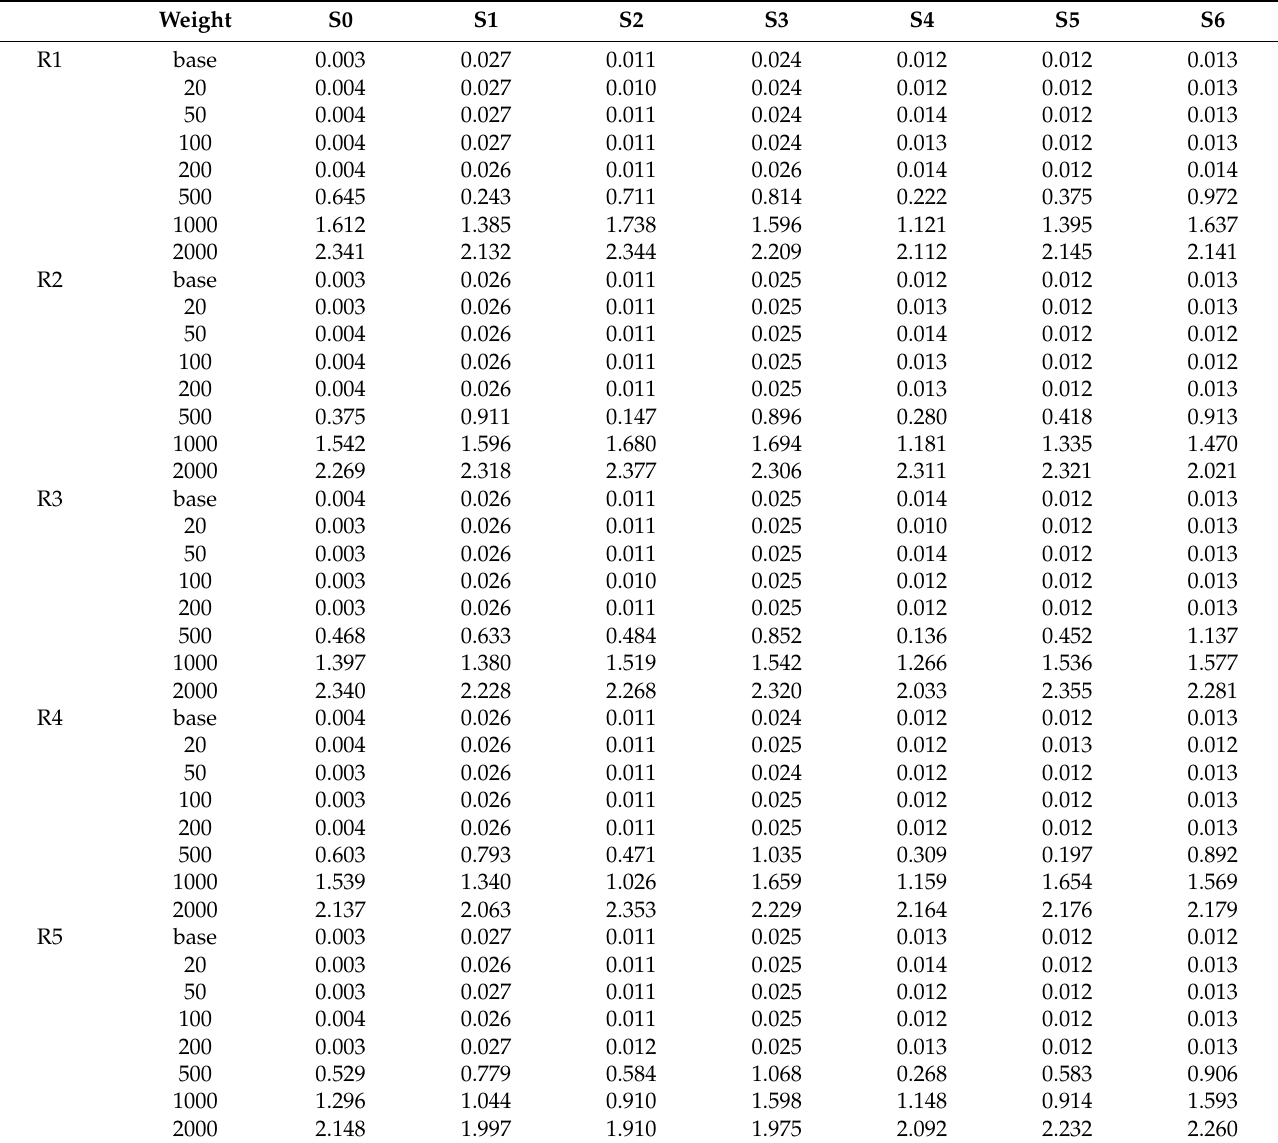
Table 5. Resistive plantar